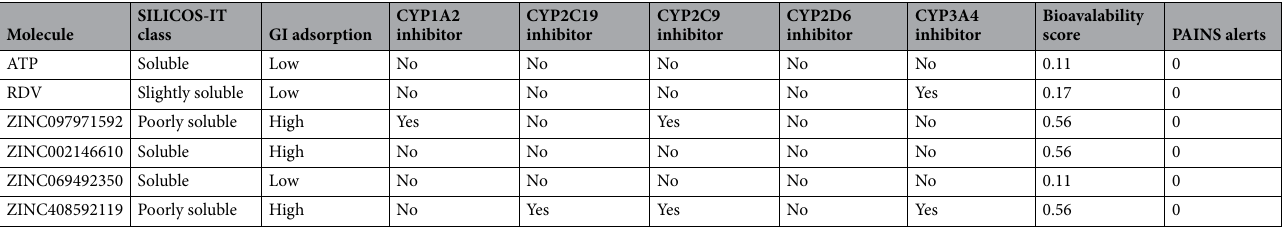
Table 5. Summary of drug property predictions of ATP, RTP and top four ZINC candidates obtained from the SwissADME